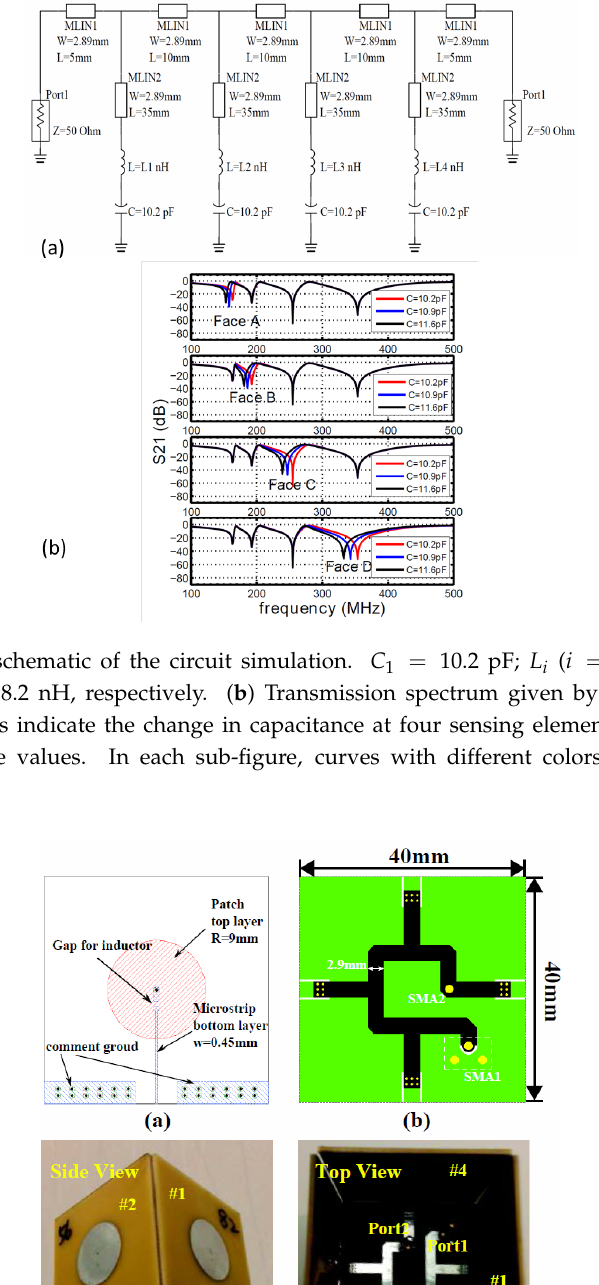
50 Ω transmission line located on the bottom layer of the PCB with a via, while the ground plane sits in the middle layer, with a 1.2-mm spacing between the top layer and a 0.3-mm spacing between the bottom layer.